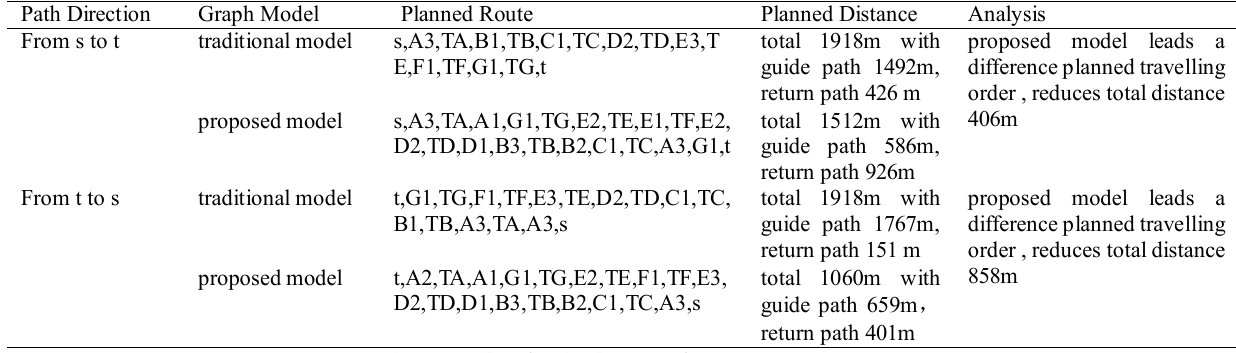
Tab. 3. Results of Path Planning of Experiment